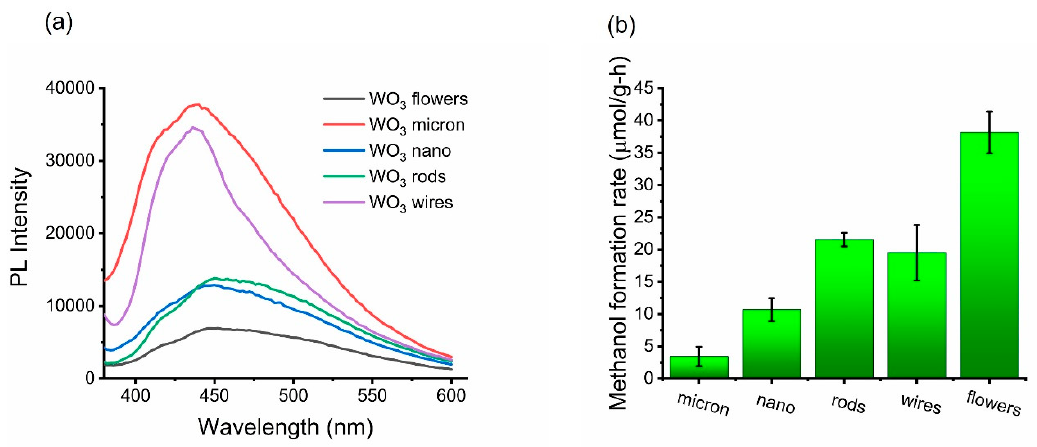
Figure 5. ( a ) Photoluminescence emission spectra of WO 3 particles ( b ) Methanol formation rate for morphology/2 mM H 2 O 2 (reaction conditions: temperature of 50 °C, pH~7, UV light irradiation, CH 4 /N 2 bubbling with 100 mL/min).